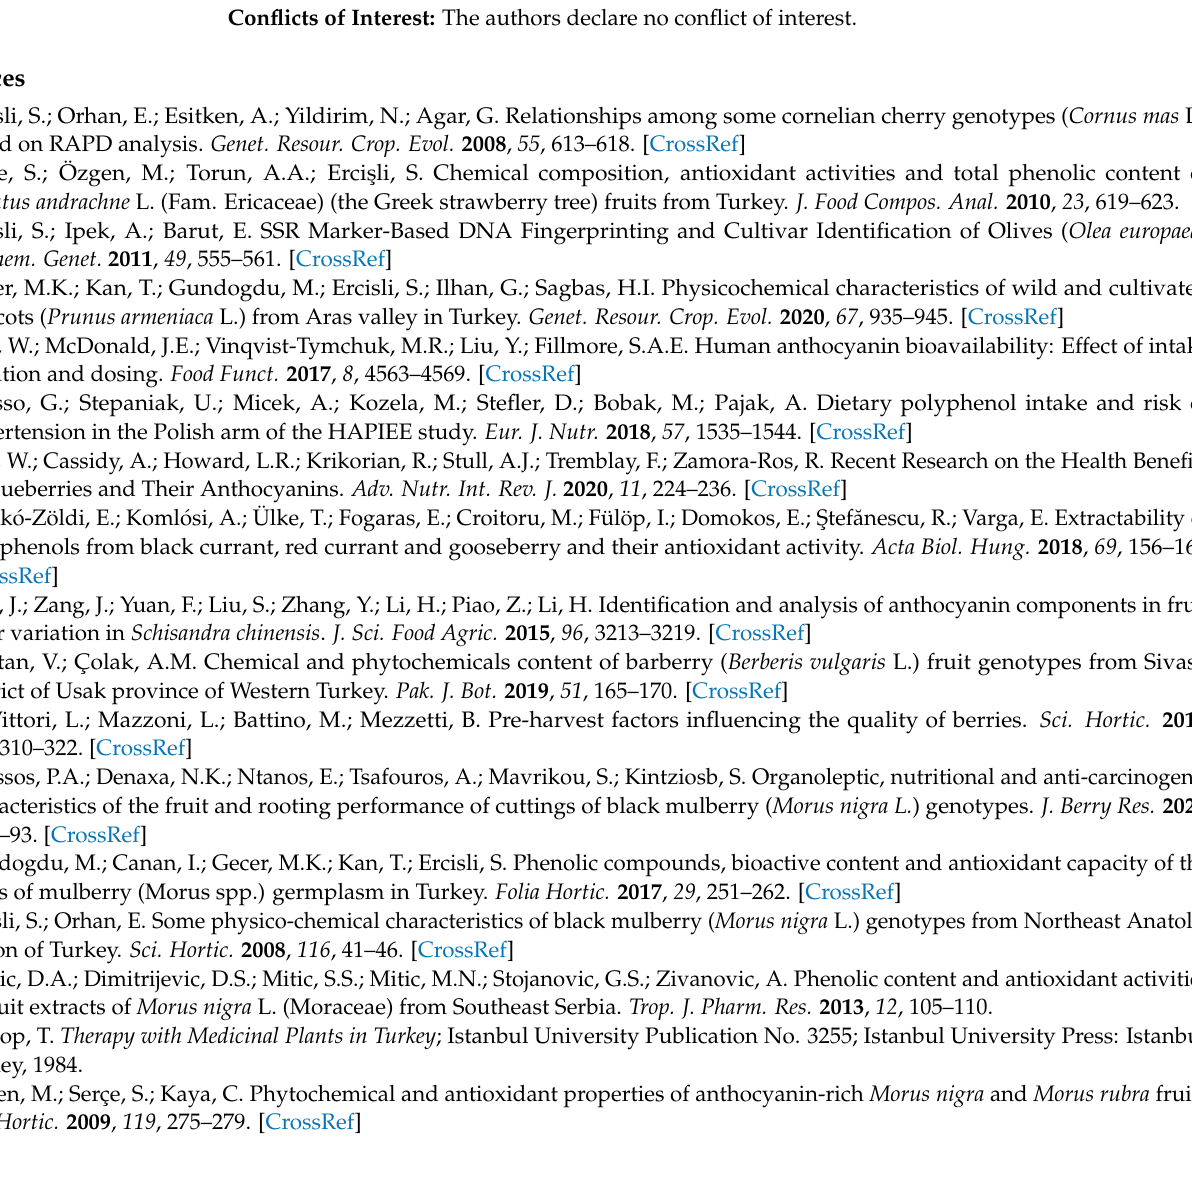
Table S3: Content of organic acids in fruits of M. nigra